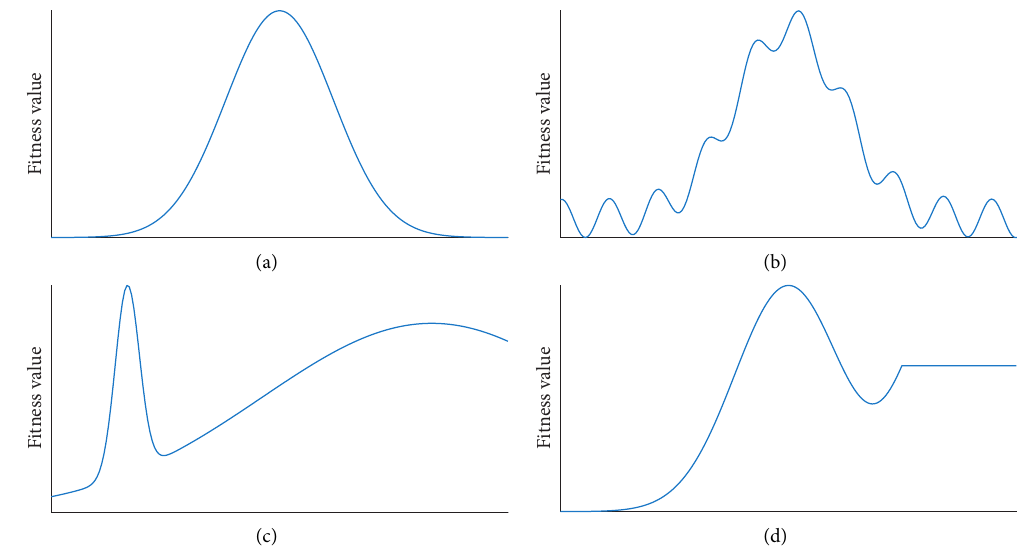
Figure 1: Landscape features adapted from Malan and Engelbrecht [42]. The landscapes are representations of different types of fitness functions where each position in the landscape has a fitness value. (a) Smooth landscape. (b) Rugged landscape. (c) Deceptive landscape. (d) Neutral